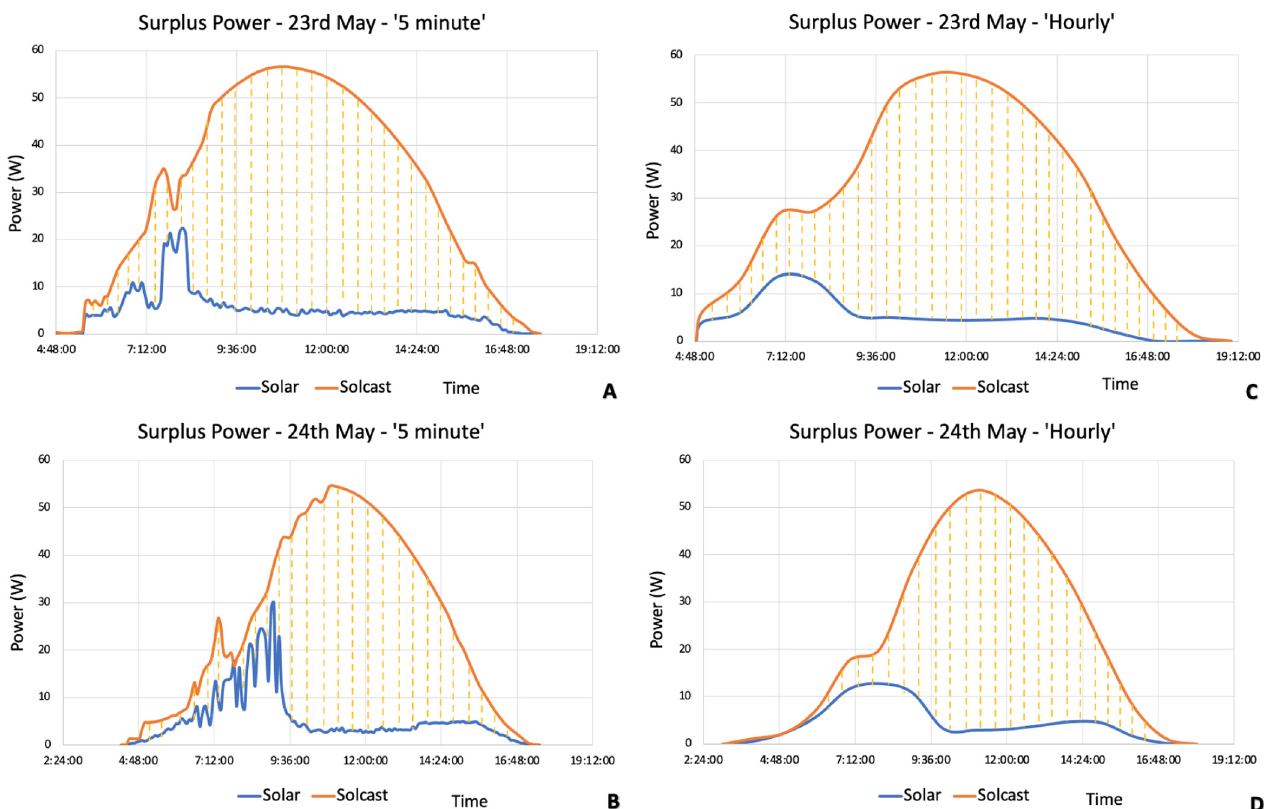
Fig. 5. Surplus Power on a 5-minute scale; (A) 23rd May, (B) 24th May and Surplus Power on an hourly scale (C) 23rd May; (D) 24th